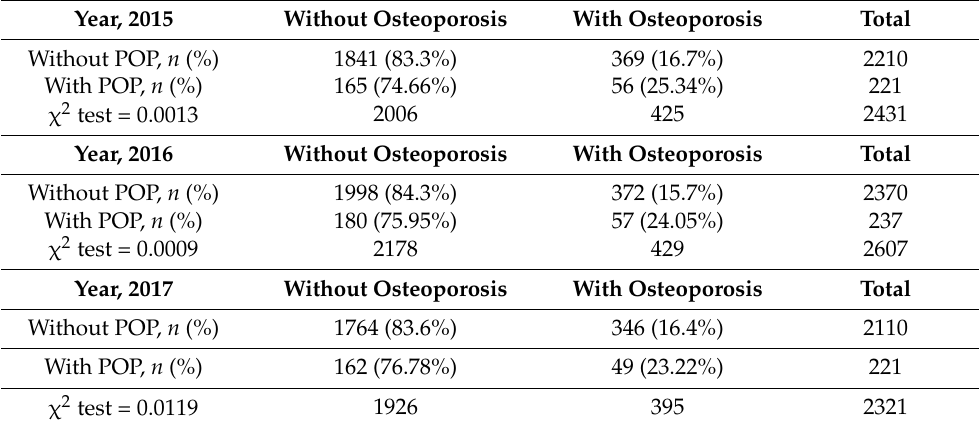
Table 4. Pelvic organ prolapse (POP) and osteoporosis prevalence in women aged over 50 years (1:10 age-stratified matching model).